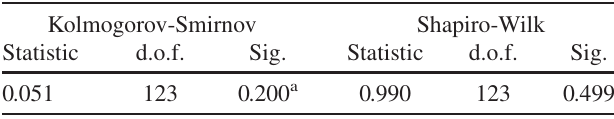
TABLE IX. Normality checks for standardized residuals.